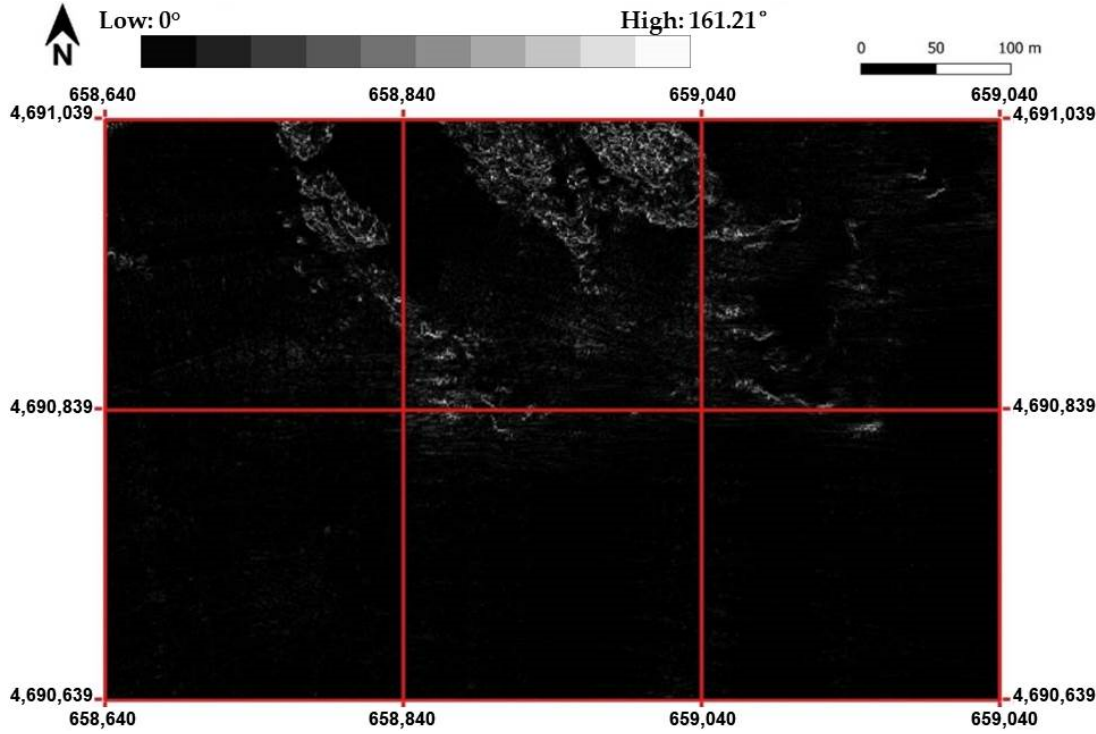
Figure 11. The slope variations (in degree) along y direction.